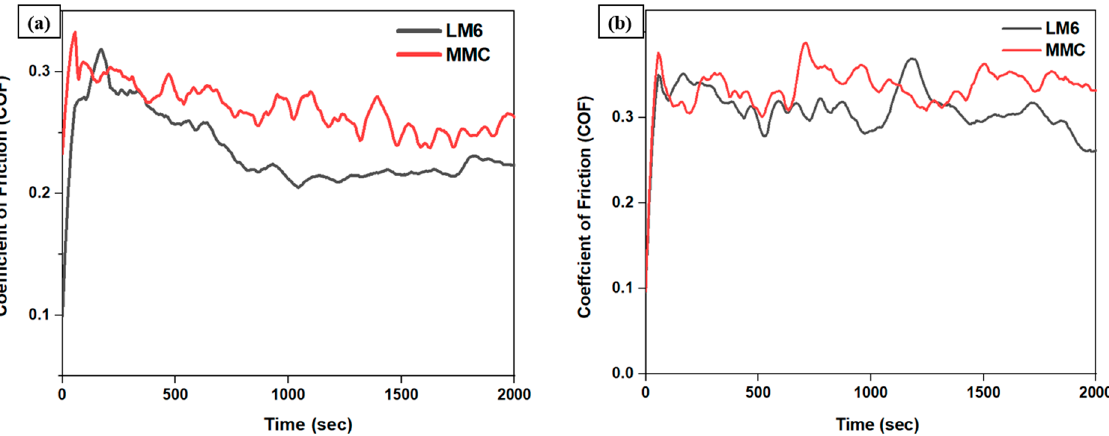
Figure 8. Comparative CoF plots of LM6 and MMC at ( a ) room temperature and ( b ) elevated temperature of 175 °C .